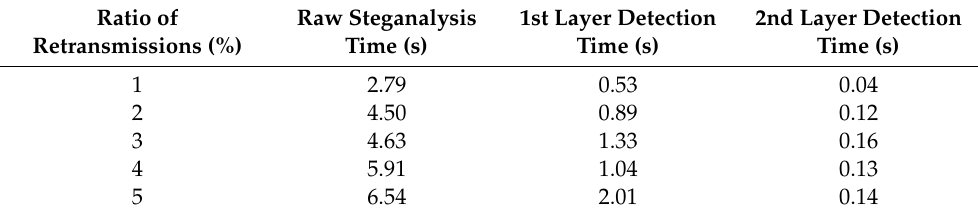
Table 2. Steganalysis performance.